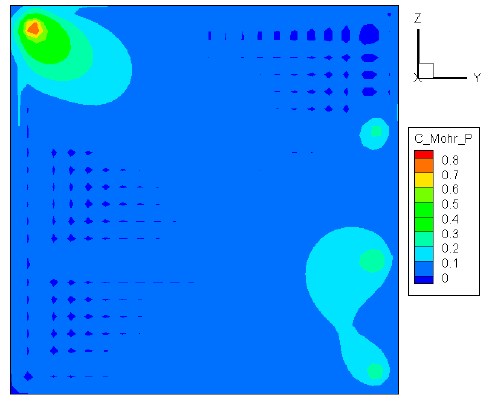
Figure 9. Distribution of